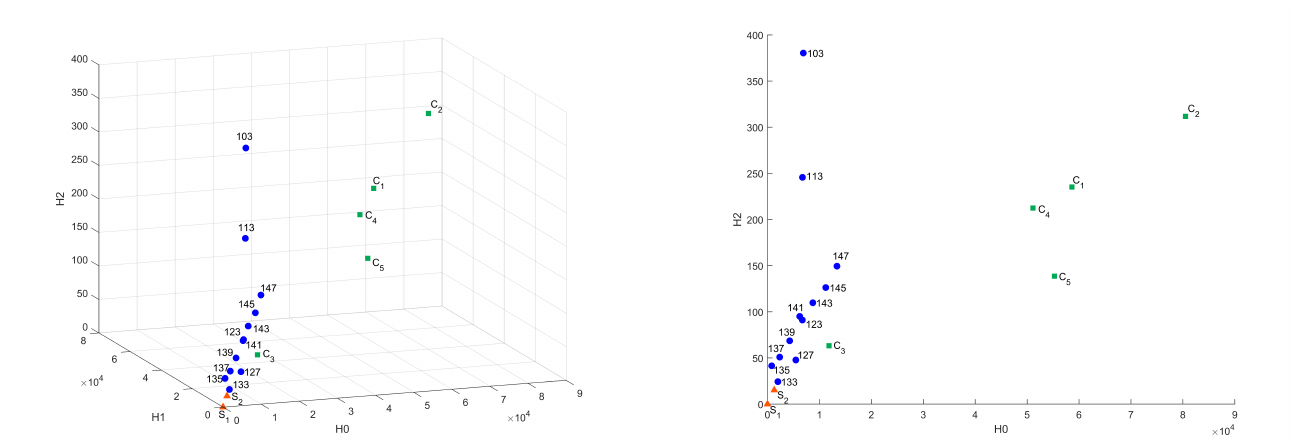
Figure 12. Influence of the binarization threshold of A sample in Sliced Wasserstein metric in 3D and H 0 – H 2 coordinates.